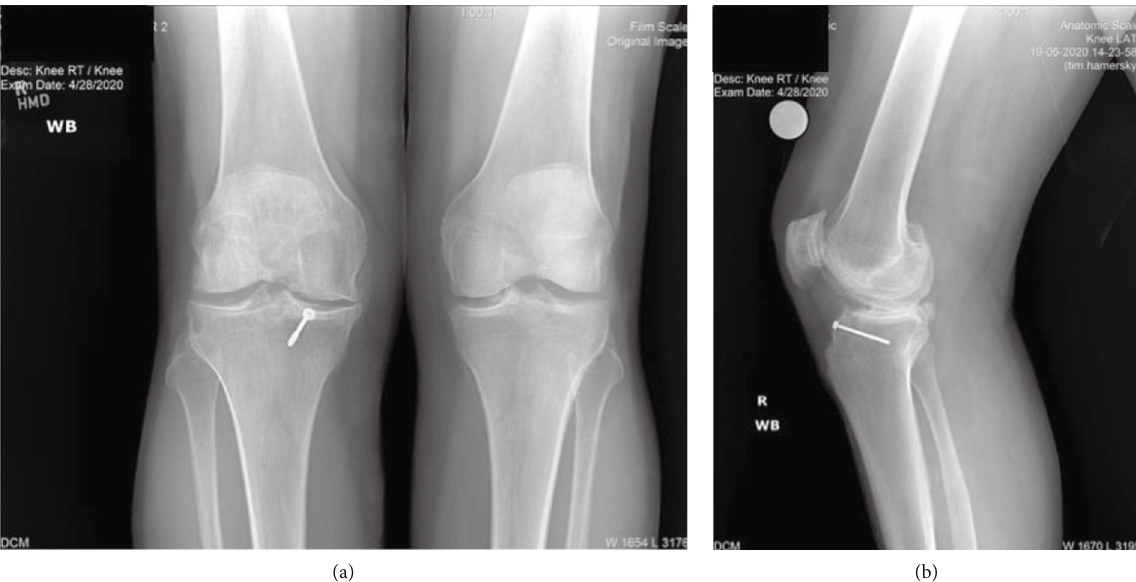
Figure 4: Preoperative weight bearing radiographs of Case 2 showing the tricompartmental arthritic changes of the right knee on the (a) anteroposterior view and (b) the arthritic changes of the knee on the lateral